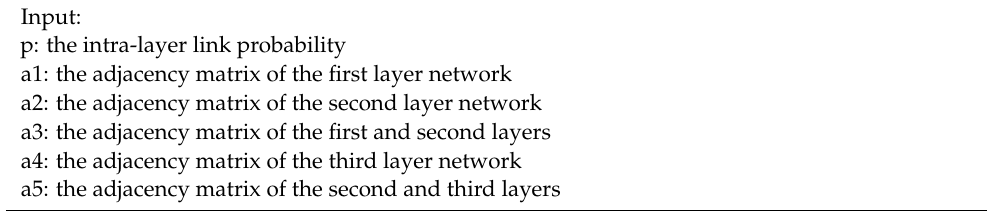
Algorithm 1 Disease spreading behavior oriented to three-layer complex